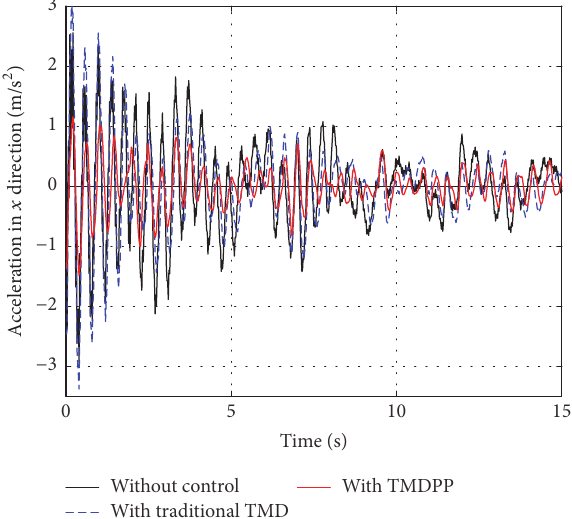
Figure 10: Damping comparison of structural acceleration in 𝑦